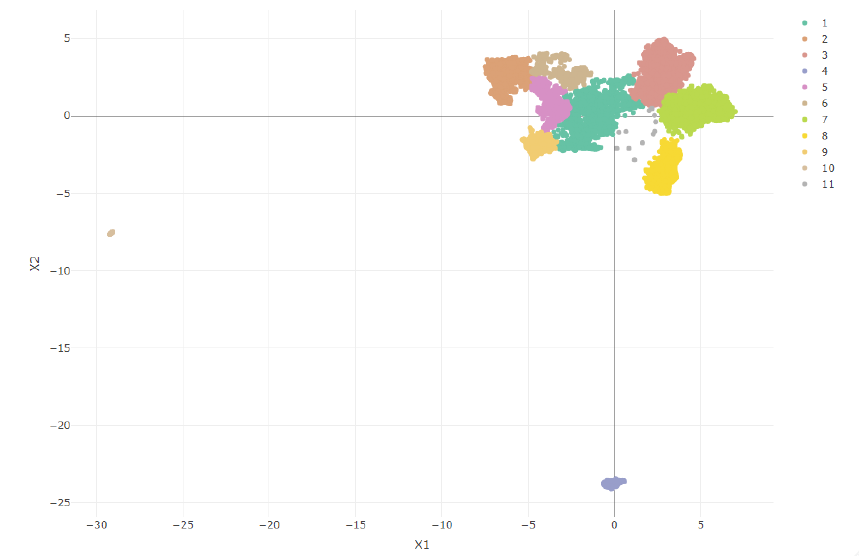
Figure 5. UMAP two-dimensional space projection with Ward’s clusters